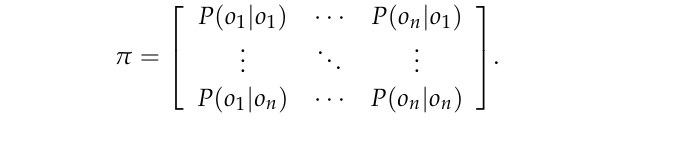
Algorithm 1: Modified LZW encoding